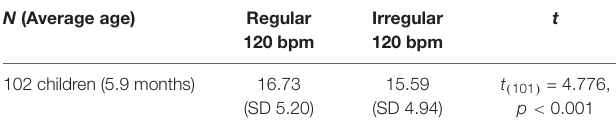
TABLE 1 | Mean scores and SD for the task presented at 120